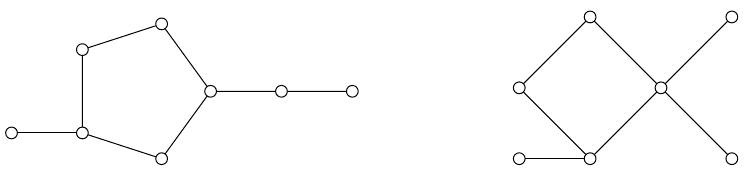
Figure 1. The graph on the left is type 1, and the one on the right is type